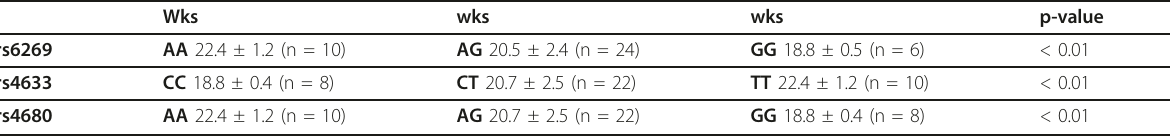
Table 5 Genotype and gestational age at laser treatment (mean ±